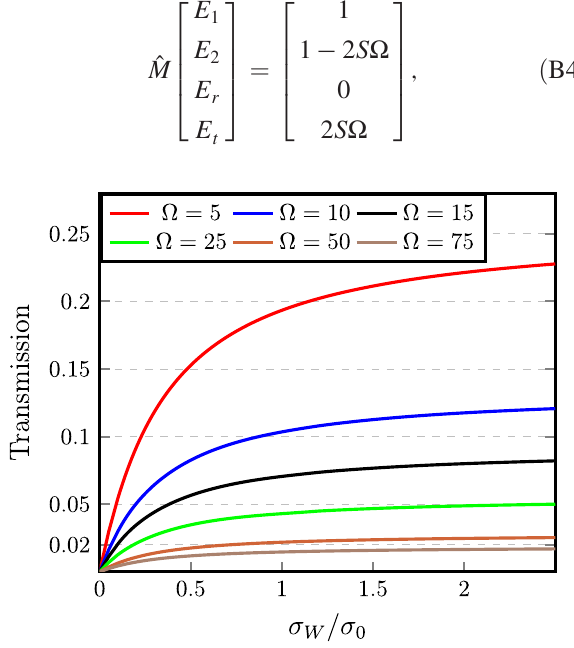
FIG. 8. The transmission coefficient as a function of S ¼ = σ σ W 0 for different values of